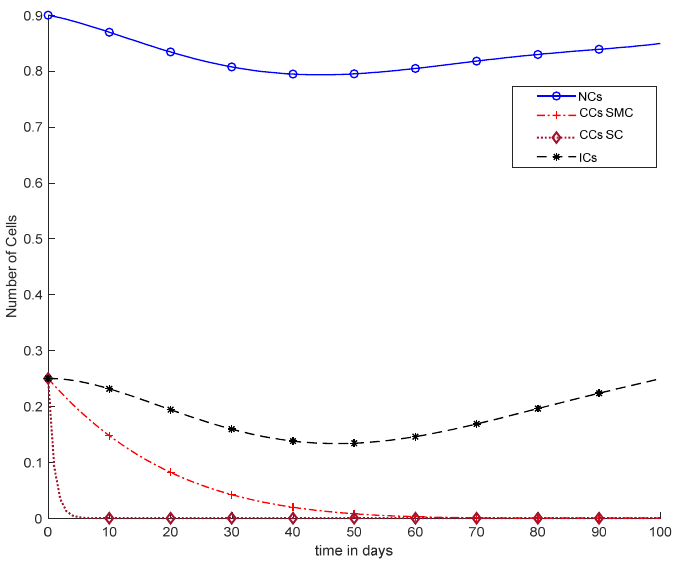
Figure 13. With chemotherapy at a constant dose, SMC on CCs (‘+’ line), and SC on CCs (‘ − ’ line) with effect on all equations.